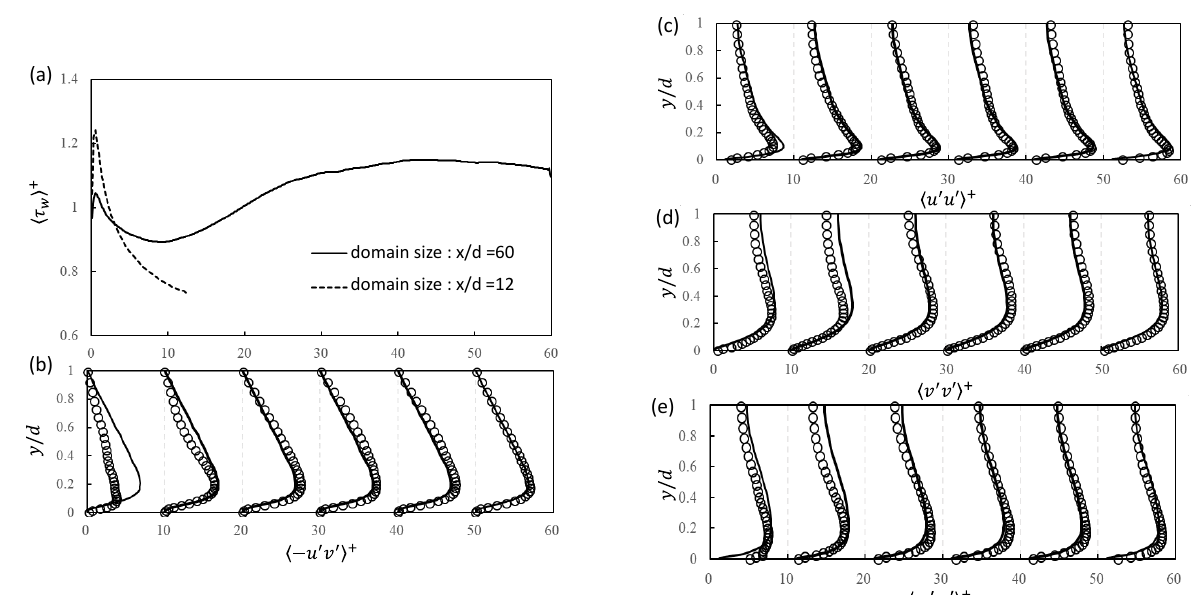
Figure 4. Spatial development of: ( a ) dimensionless wall shear stress; ( b ) shear stress; ( c ) axial stress (longitudinal); ( d ) axial stress (vertical); ( e ) axial stress (spanwise). Figure 4c–e indicates the variation of axial stress profiles along the whole